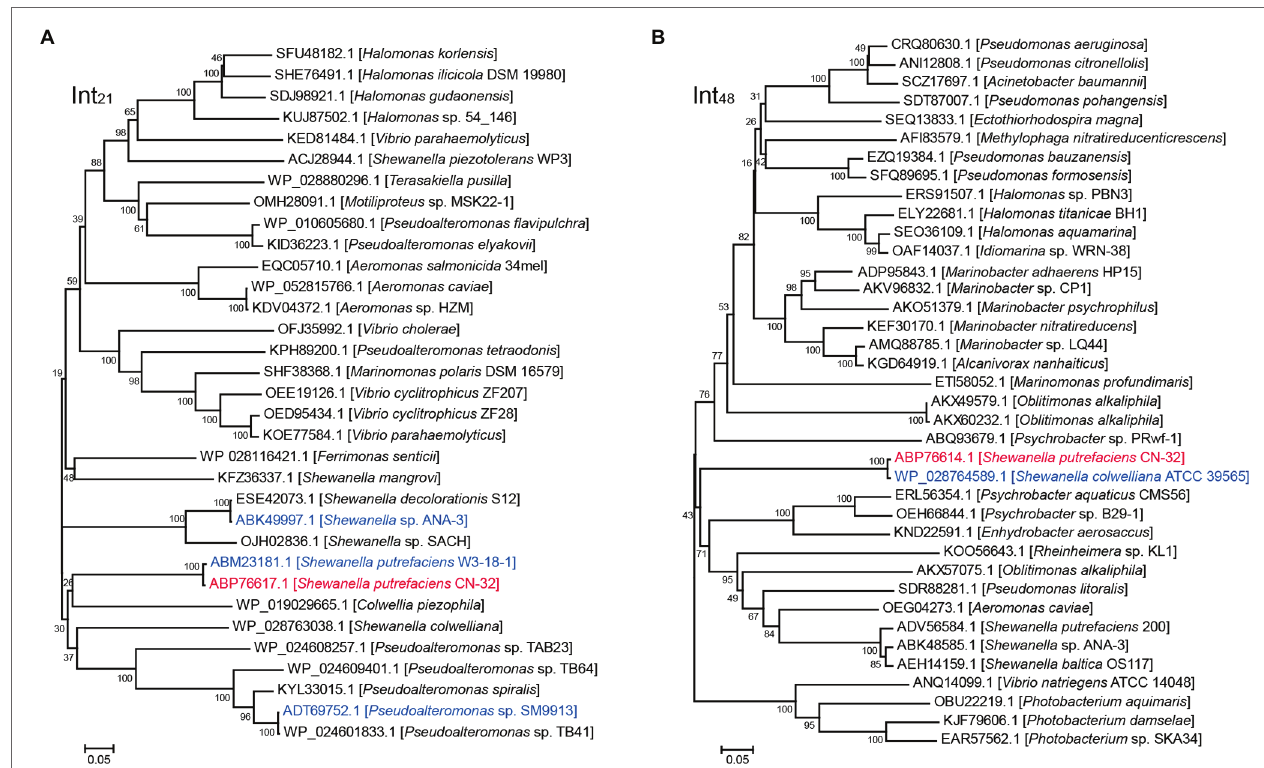
FIGURE 3 | Phylogenetic analysis of Int 21 and Int 48 homologs. (A) Neighbor-joining phylogenetic tree of 32 homologs of Int 21 , and (B) 37 homologs of Int 48 based on amino acid (aa) sequences. Proteins with homology to Int 21 and Int 48 were selected by BLASTp at the NCBI server. CN32 was indicated in red, and other genomic islands shown in Figure 2A were indicated in